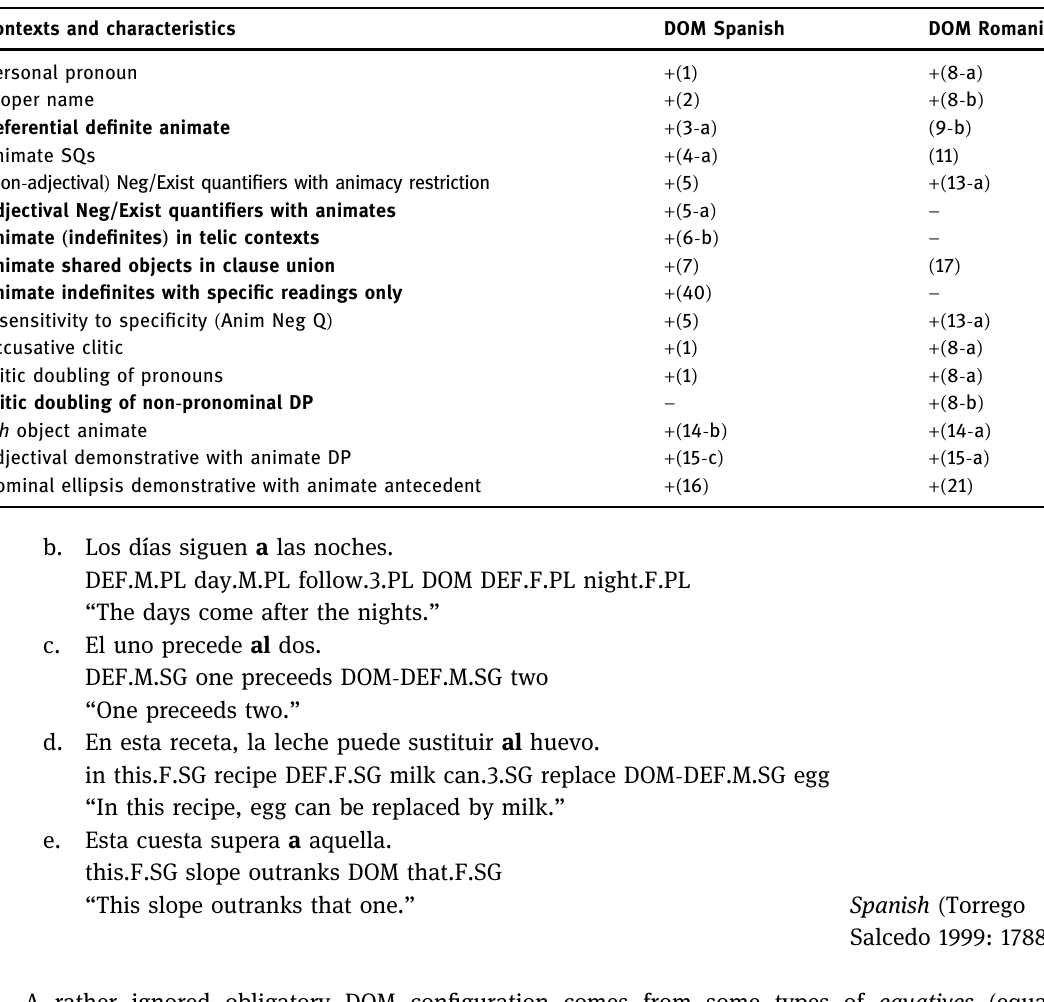
Table 2: DOM – standard Spanish and Romanian animates ( preliminary )